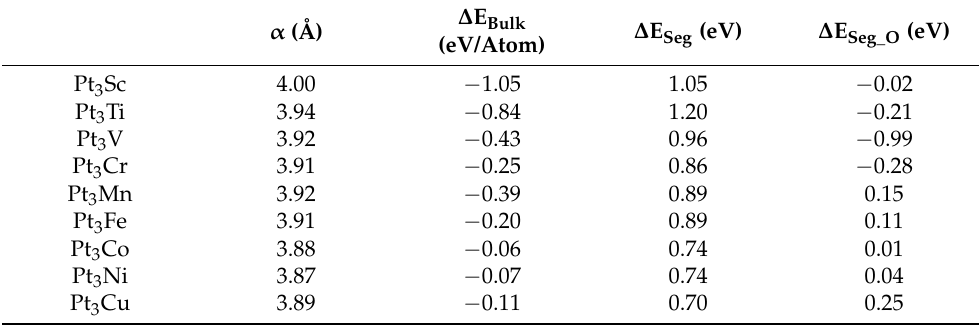
Table 1. Calculated lattice parameters, bulk formation energy, and segregation energy with and without oxygen